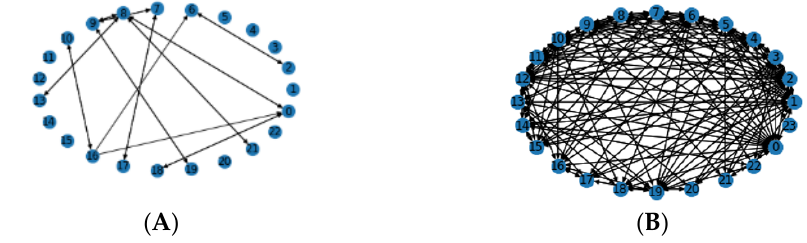
Figure 2. Examples of dense and sparse graphs representing CAs for two distinct samples in ( A ) breast cancer (large number of aberrations (such as 2 → 6, 6 → 2, 16 → 6, 7 → 17, 17 → 7, 8 → 21, 21 → 8, etc.)) and ( B ) prostate cancer (few aberrations (such as 2 → 5, 4 → 10, 17 → 3, 17 → 7, 8 → 21, 21 → 8, etc.)).